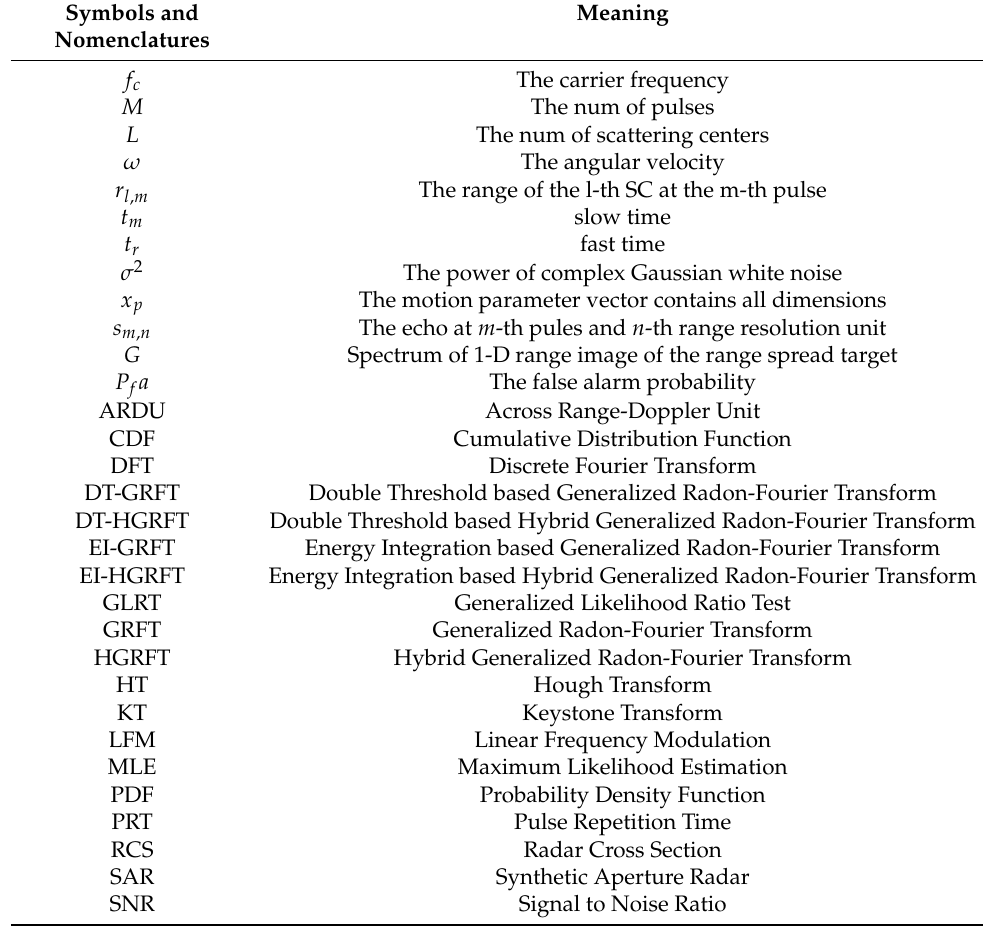
Table A1. Illustration for the meaning of symbols and nomenclatures in this manuscript Symbols